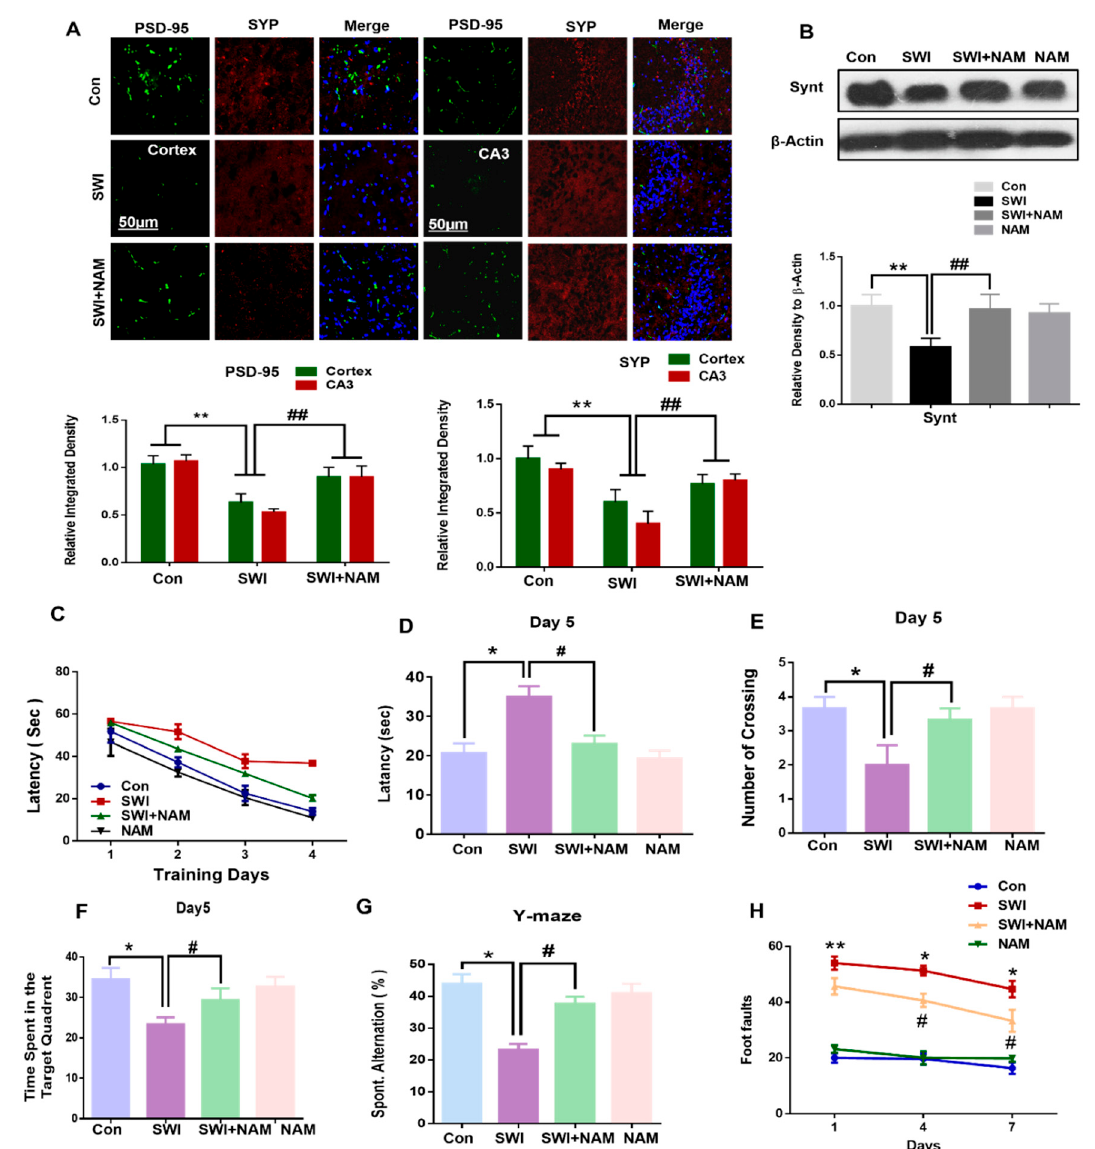
Figure 7. NAM reversed brain-injury-induced synaptic protein loss and memory impairment in the mice brain. ( A ) Confocal microscopy images represent the double immunofluorescence of PSD-95 and synaptophysin, among the treated groups. ( B ) Immunoblots and histogram represent the expression of synaptic protein syntaxin, among the treated groups. ( C,D ) The histogram represents latency to target platform, during training and during probe test, respectively. ( E ) Histogram showing the number of crossing during the probe test, on day 5. ( F ) Histogram of the time spent in the target quadrant during the probe test, on day 5. ( G ) Histogram showing the spontaneous alternation (in %) in the Y-maze behavior analysis. ( H ) Represents the foot faults at different time intervals, among the treated groups. The data are shown as a mean ± S.E.M. All values were taken from three independent experiments. Statistical analysis was done through one-way ANOVA analysis. P < 0.05 was considered to be statistically significant. The symbols * P < 0.05, and ** P < 0.01 represent significant differences between the control and SWI; # P < 0.05, and ## P < 0.01 represent significance differences between SWI and SWI plus NAM.